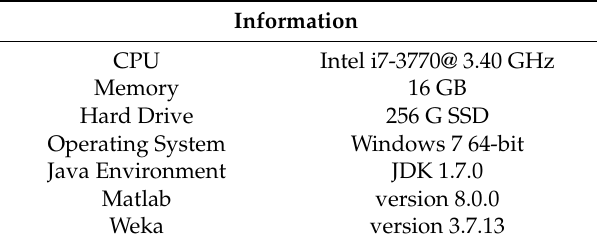
Table 2. Node configuration